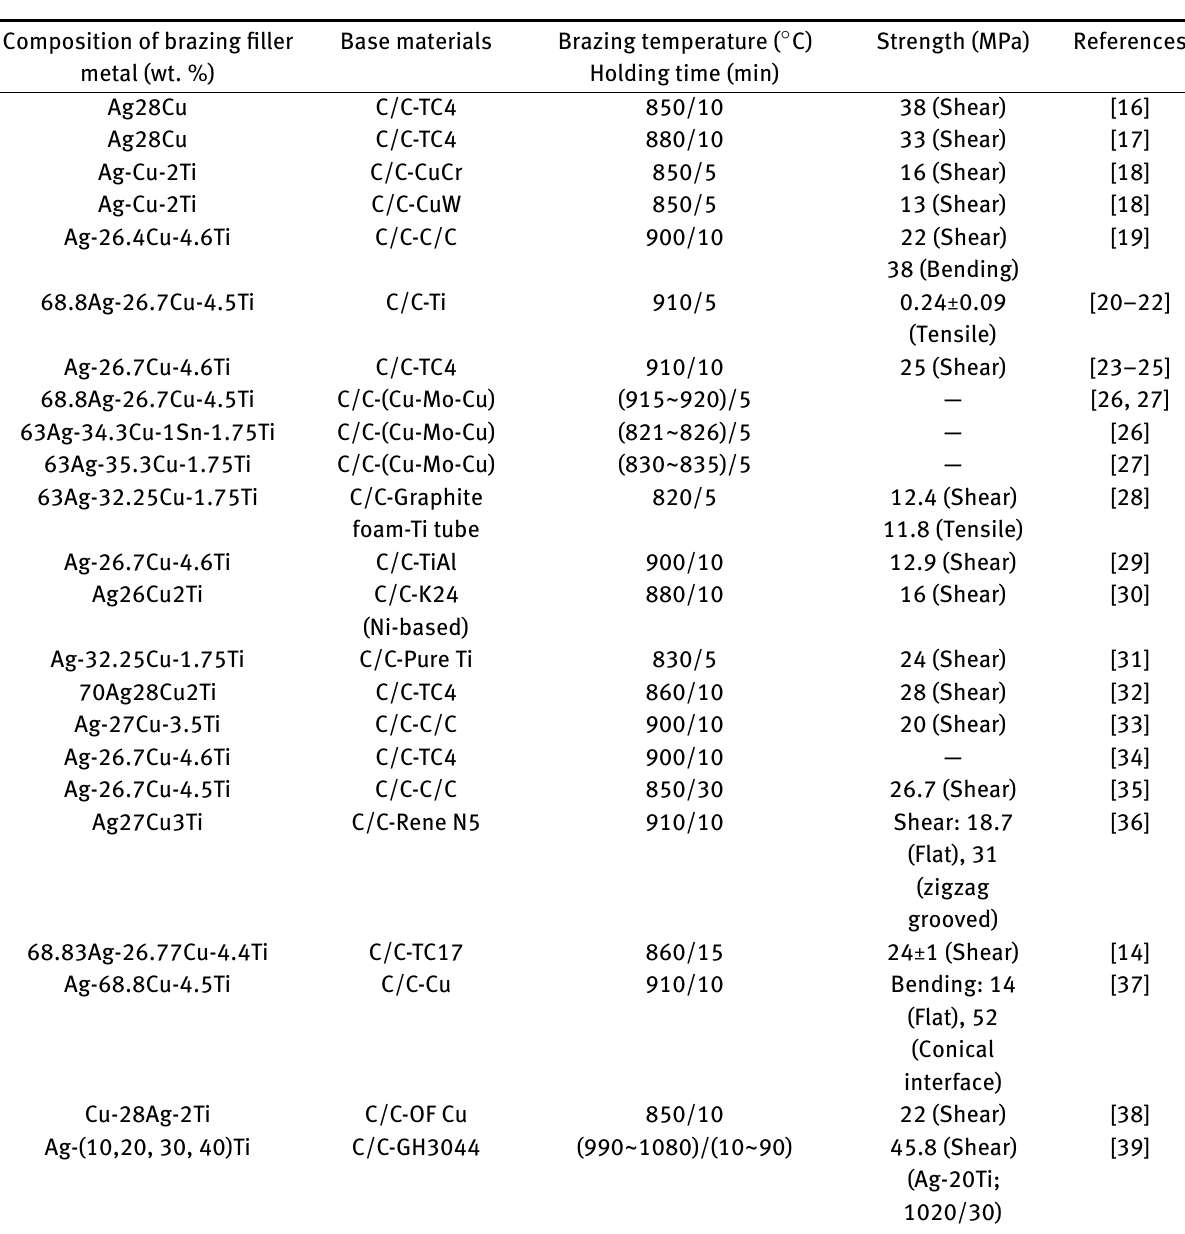
Table 2: Ag-based brazing filler metals used in joining of C/C composites Composition of brazing